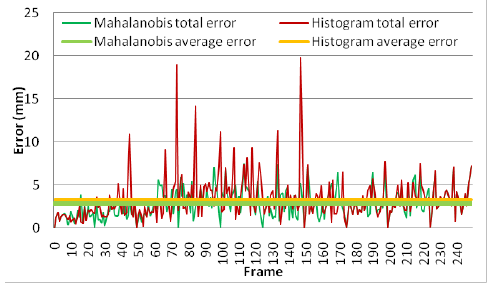
Figure 20. IPB estimation accuracy for the cube synthetic sequence.